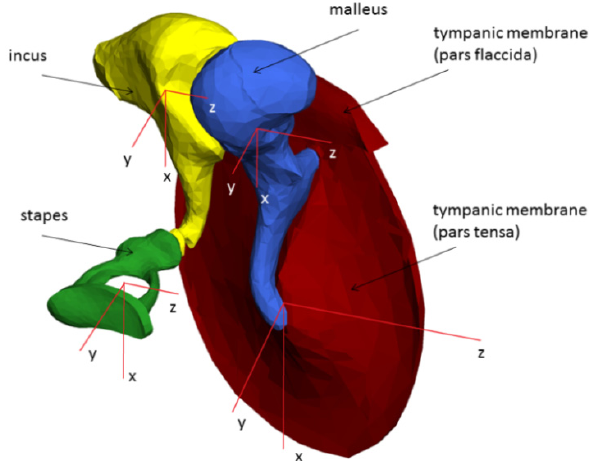
Figure 4. Tympanic membrane (red), malleus (blue), incus (yellow) and stapes (green), including local coordinate systems originating in the centers of gravity, are given for